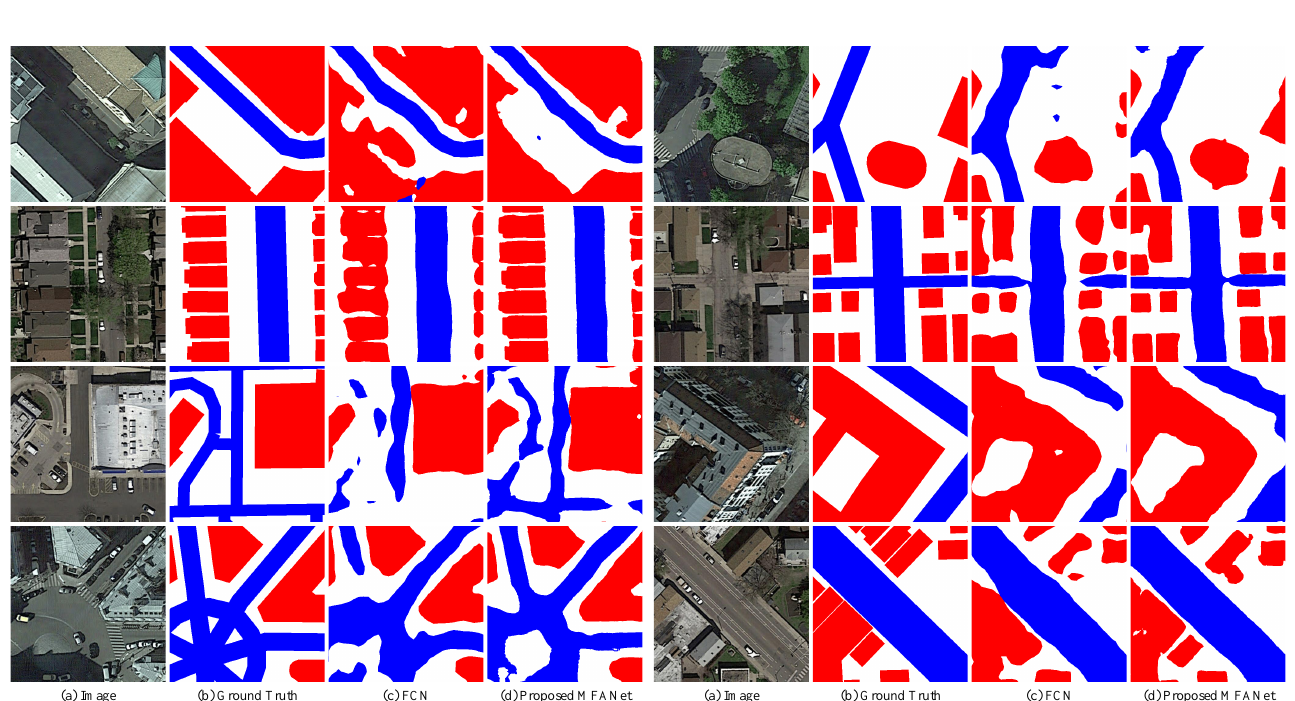
Figure 10. Results of MFANet on AISD testing set. ( a ) The original images; ( b ) Corresponding labels; ( c ) The predicted maps of FCN; ( d ) The predicted maps of proposed